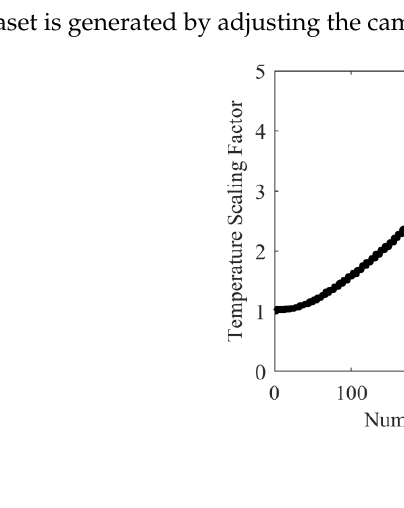
Table 1. The distribution of the constructed road image part dataset with noised